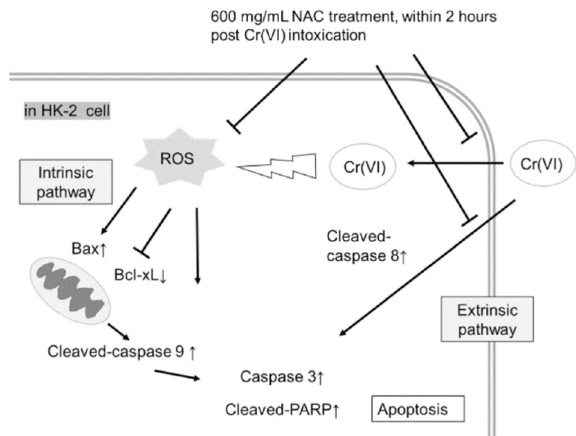
Figure 6. Proposed scheme of NAC treatment. Cr(VI) exposure induced ROS and then activated apoptotic pathways in human epithelial renal proximal tubule cells. In addition, extrinsic pathways were induced by an unknown mechanism. NAC treatment within 2 h post Cr(VI)-induced toxicity effectively rescued cells from apoptosis.